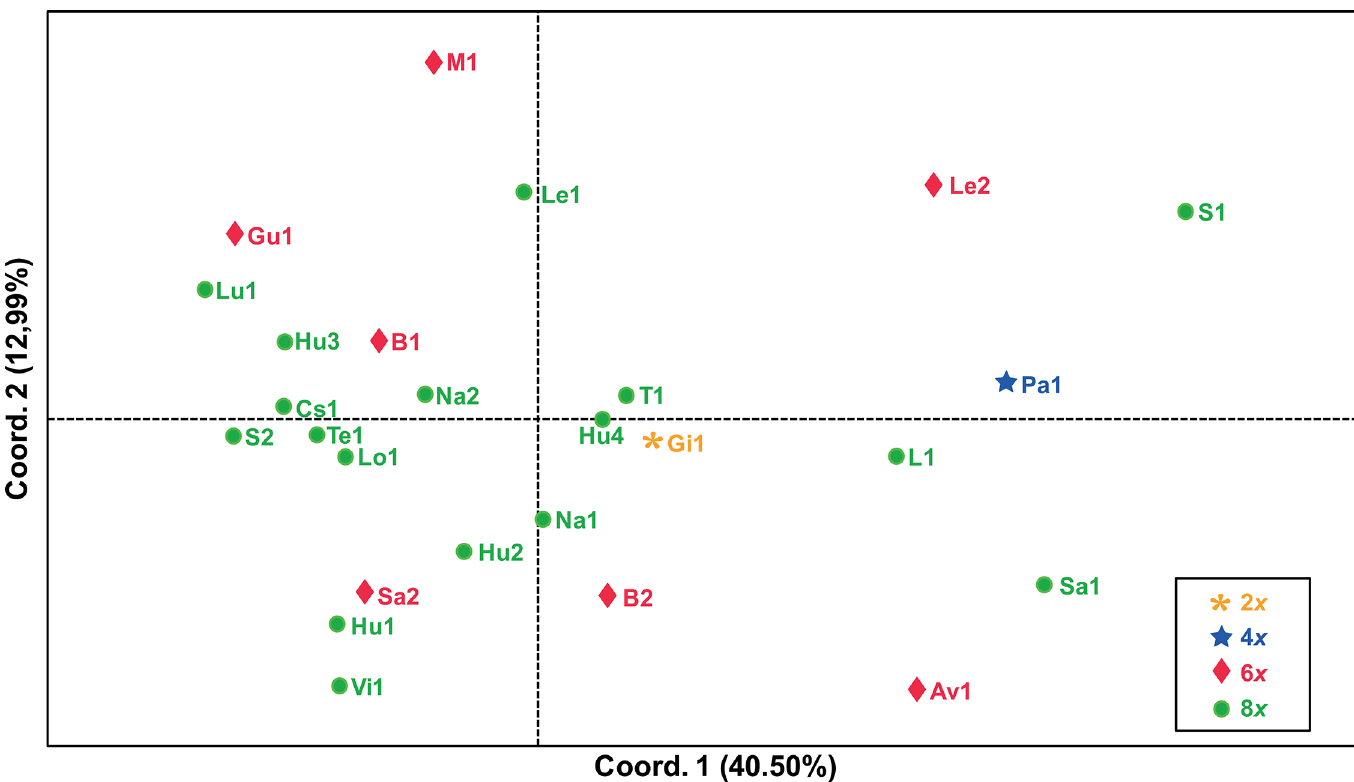
Fig 7. Principal component analysis performed from pairwise Nei ’ s genetic distances between populations. Orange asterisk: 2 x ; blue star: 4 x ; pink diamond: 6 x ; green dot: 8 x . See Table 1 for population codes.